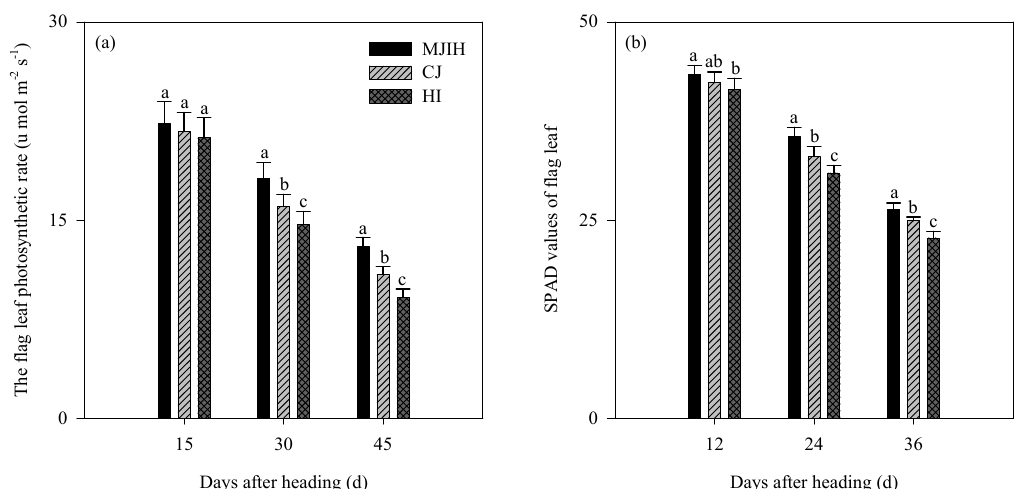
Figure 3. The leaf photosynthetic rate ( a ) and SPAD values of flag leaf ( b ) of rice cultivars. EJIH, early-maturing japon- ica/indica hybrids; CJ, conventional japonica rice; HI, hybrid indica rice. Means followed by different letters within a growth period are significantly different at the 5% probability level. Vertical bars represent the mean ( n = 3) ± standard deviation.